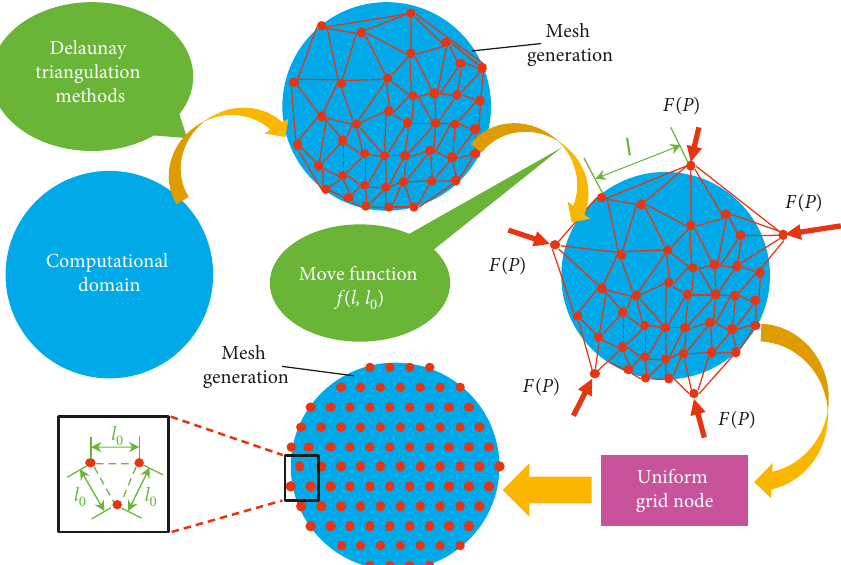
Figure 1: Schematic diagram of the optimization